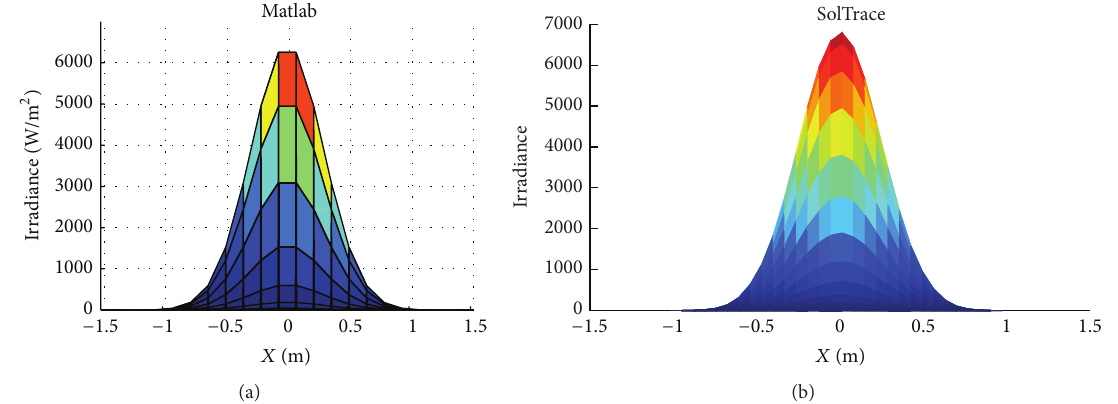
Figure 5: Comparative of solar flux in the receiver. Analytical approximation (a) and Monte Carlo method using SolTrace (b). Close heliostat located at (0, 34.13).